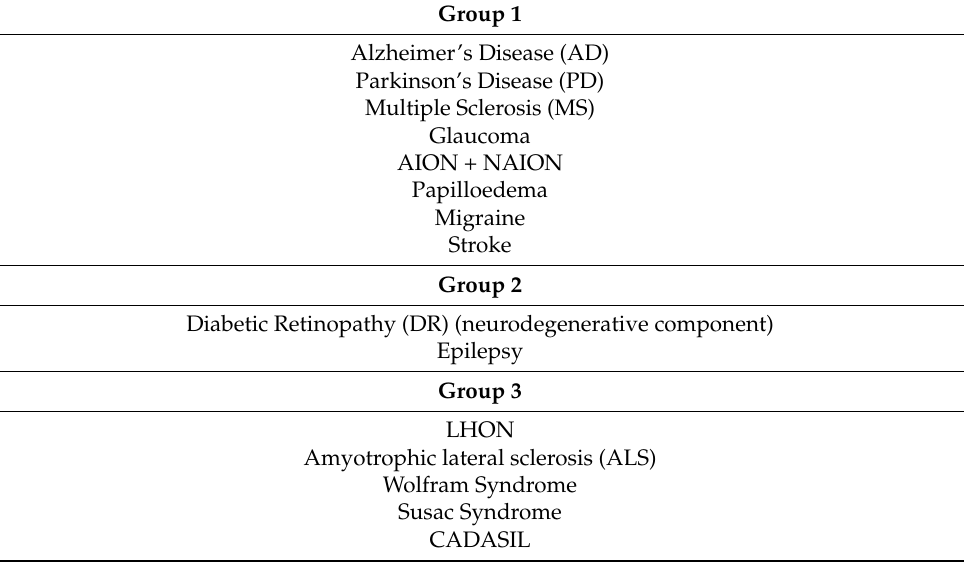
Table 1. Neurological diseases grouped for social and clinical importance. AION = anterior ischemic optic neuropathy, NAION = non-arteritic anterior ischemic optic neuropathy, LHON = Leber’s hereditary optic neuropathy, CADASIL = cerebral autosomal dominant arteriopathy with subcortical infarcts and leukoencephalopathy.